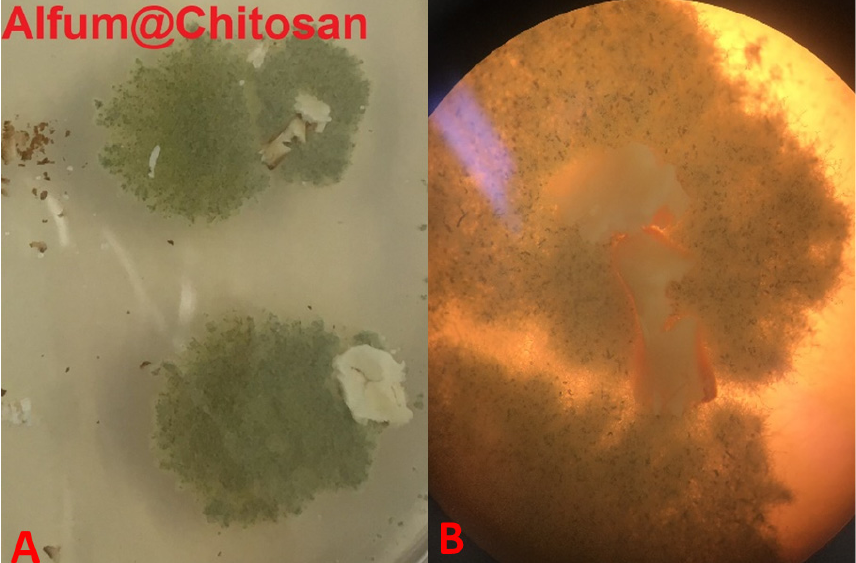
Figure 10. Pictures of the Alfum80@chitosan composite materials in the fungus test with Aspergillus falconensis . (Image ( A ): Visual naked-eye observation; Image ( B ): microscopic image).